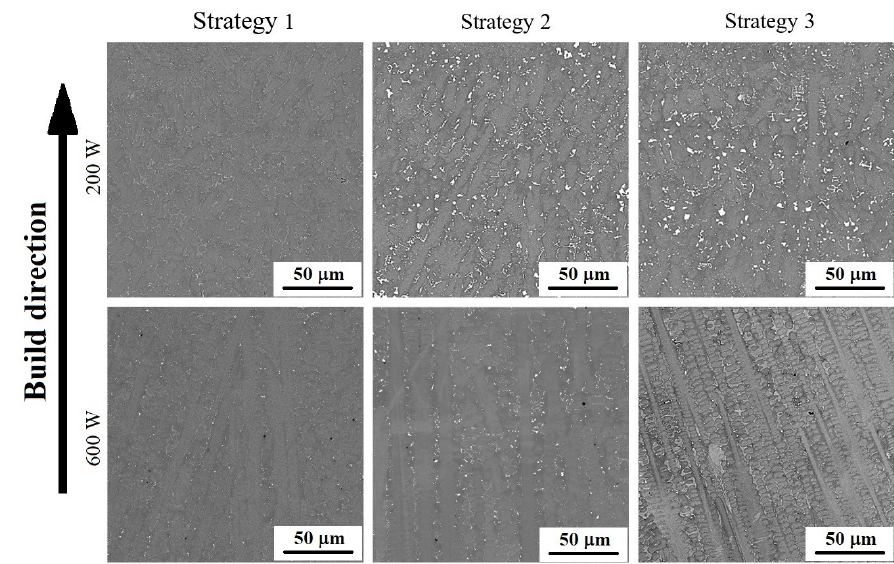
Figure 10. Macrostructure of the longitudinal section of thin walls.